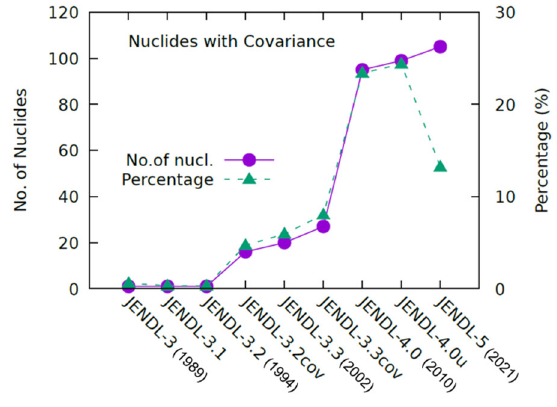
Fig. 1. The number of nuclides with covariance in JENDL